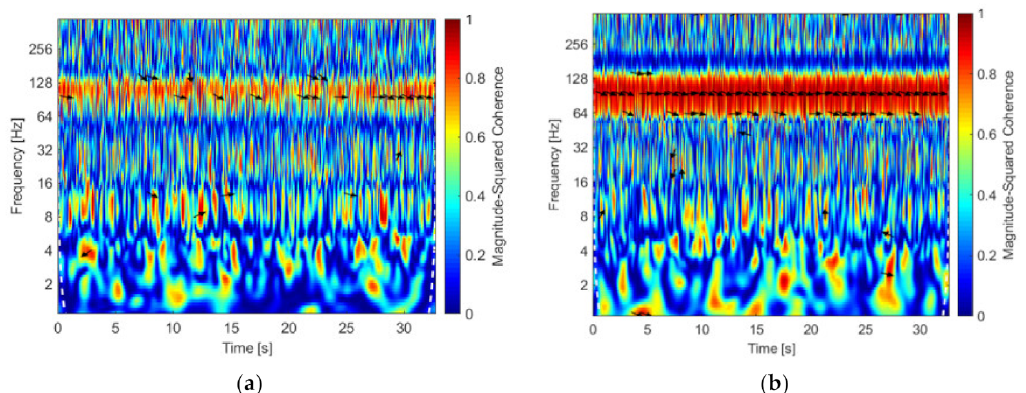
Figure 9. Wavelet coherence between wake velocity and cylinder acceleration for the reduced velocity equal to 63. ( a ) First cylinder free to vibrate and ( b ) second cylinder free to